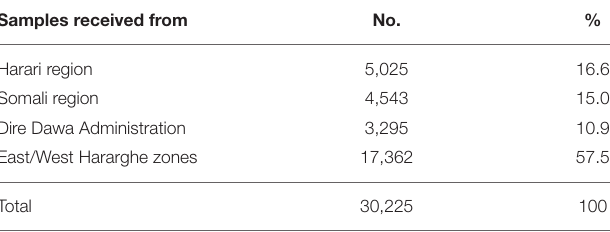
TABLE 1 | COVID-19 tests conducted during April 2020–March 2021, HHR, and CAGED Laboratories, Haramaya University, Eastern